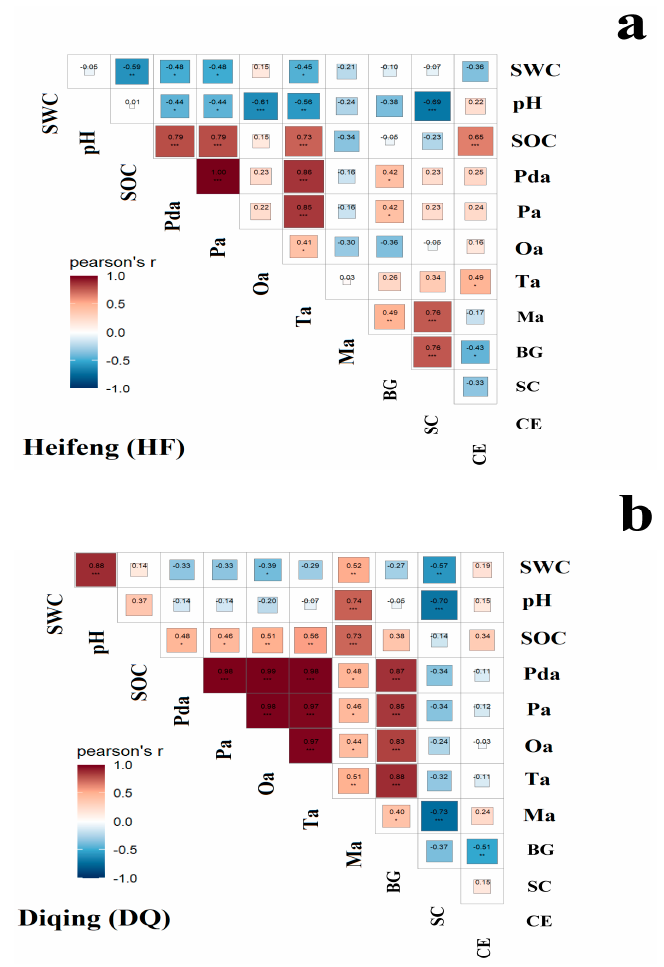
Figure 5. Pearson’s correlation analysis of environmental factors, organic acid, and C-transforming enzymes in HF ( a ) and DQ ( b ). DQ represents low soil nutrient tolerant variety and HF represents low soil nutrient sensitive variety. SOC, soil organic carbon; SWC, soil water content; Pda, malonic acid; Pa, propionic acid; Oa, oxalic acid; Ta, tartaric acid; Ma, malic acid; BG, β − glucosidase; SC, sucrase enzyme; CE, cellulase enzyme. * p < 0.05; ** p < 0.01; *** p <